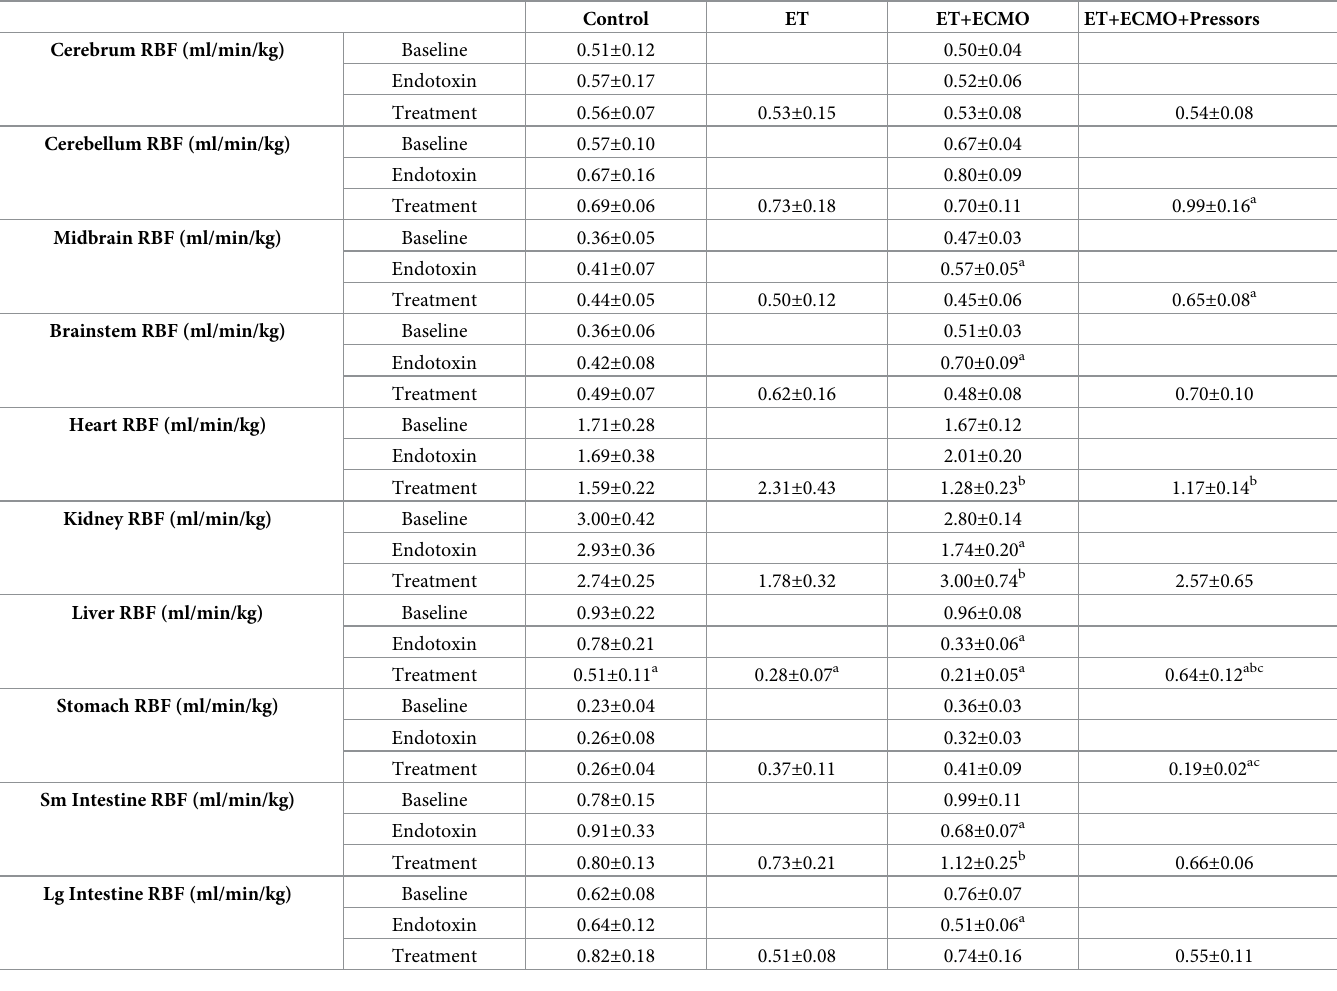
Table 2. Regional microcirculatory blood